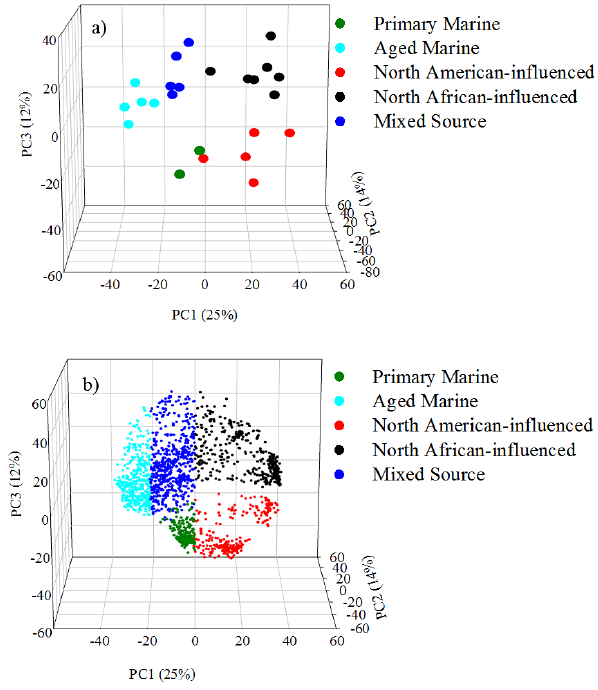
Figure 5. Three dimensional plots showing the (a) sample scores and (b) variable (molecular formulas) loadings for the first three principal components accounting for 51% of the variance in the data set. Sample data points with similar PC scores are color coded for classification of samples into sample groups with similar molec- ular characteristics. The loadings assumed to be important compo- nents of each group are similarly color